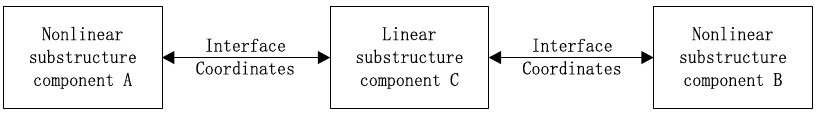
Figure 1. Connected relationship.